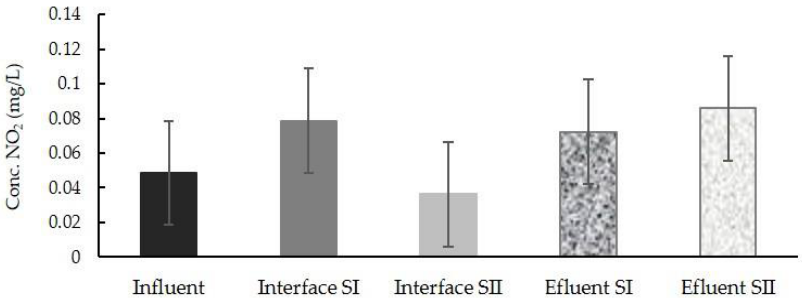
Figure 10. Nitrite average concentrations at three points of the two systems.